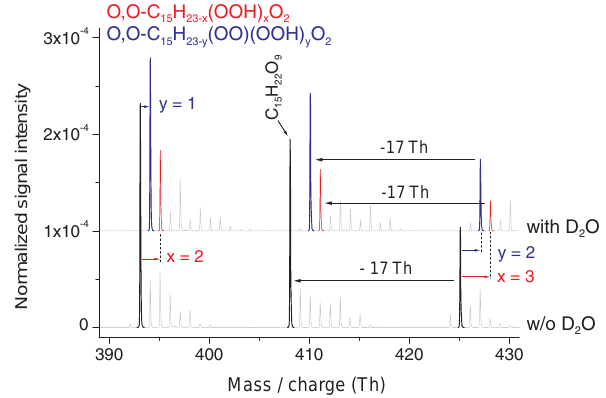
Figure 4. Ozonolysis of β -caryophyllene, in the absence (lower part) and presence (upper part) of D 2 O applying nitrate ionization in the analysis. Signals highlighted in black stand for the sum of sig- nals in the absence of D 2 O from highly oxidized RO 2 radicals of the product groups simple AutOx., O,O–C 15 H 23 − x (OOH) x O 2 with x = 2-5, and ext. AutOx., O,O–C 15 H 23 − y (OO)(OOH) y O 2 , with y = 1–4, and the corresponding closed-shell product C 15 H 22 O 7 , C 15 H 22 O 9 , C 15 H 22 O 11 , C 15 H 22 O 15 . The addition of D 2 O leads to an H/D exchange of all acidic H atoms present in the molecule. Accordingly, signals from the two product groups are separated by their number of acidic H atoms and the split-up signals are highlighted in red for the simple AutOx. group and in blue for the ext. AutOx. group. The signal at nominal 361Th can be com- pletely assigned to the RO 2 radical O,O–C 15 H 23 − x (OOH) x O 2 with x = 1 and is highlighted in red. [ β -caryophyllene] = 8 . 3 × 10 10 , [O 3 ] = 1 . 02 × 10 12 moleculescm − 3 , reaction time is 7.9s.